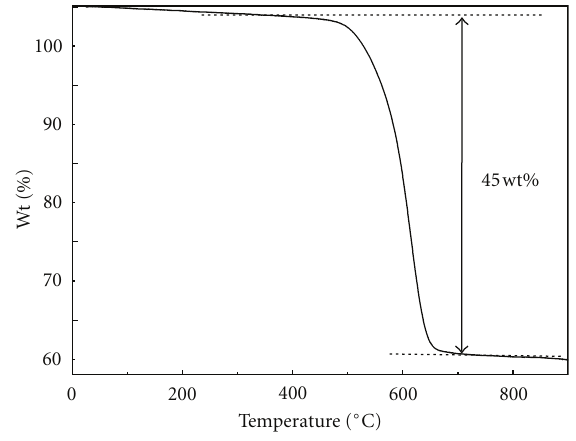
Figure 4: TGA curve of Pd/CNTs/CoMoO 4 /silica catalysts.